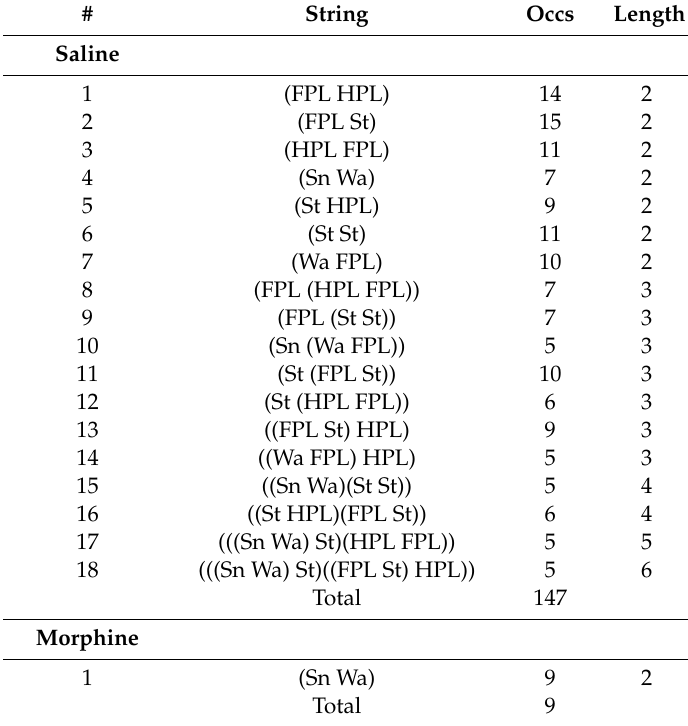
Table 1. Results of T-pattern detection in both groups of rats (morphine: 12 mg / kg IP in a volume of 1 mL of saline; saline: Volume of 1 mL) expressed as terminal strings (events in brackets). Progressive numbers on the left of each string indicate the corresponding string’s identification number. Numbers on the right of each string indicate overall occurrences (Occs) and length (i.e., number of events in the T-pattern’s structure). Data obtained from the analysis of two groups each encompassing 10 subjects. For abbreviation see Figure 1.